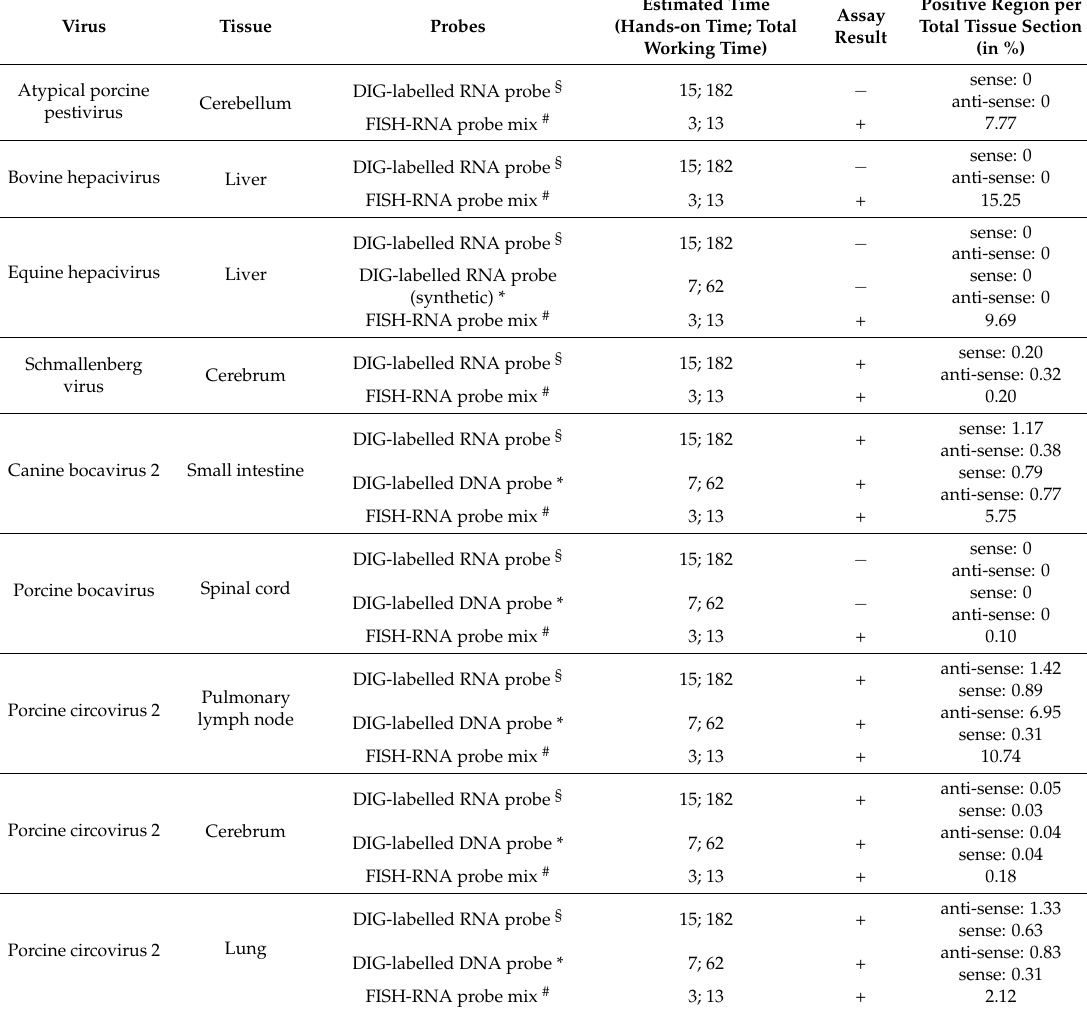
Table 2. Overview of viruses, tissues and probes used in the present study as well as the estimated working time and positive area within tissue using different probes displaying probe specific